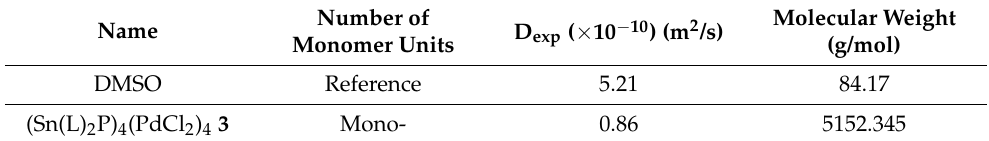
Table 3. Summary results of DOSY NMR experiments, the molecular weight and the diffusion coefficient values for the cyclic tetramer with octopamine 3 . The molecular weight and diffusion coefficient of DMSO-d6 are used as reference in the calculations.